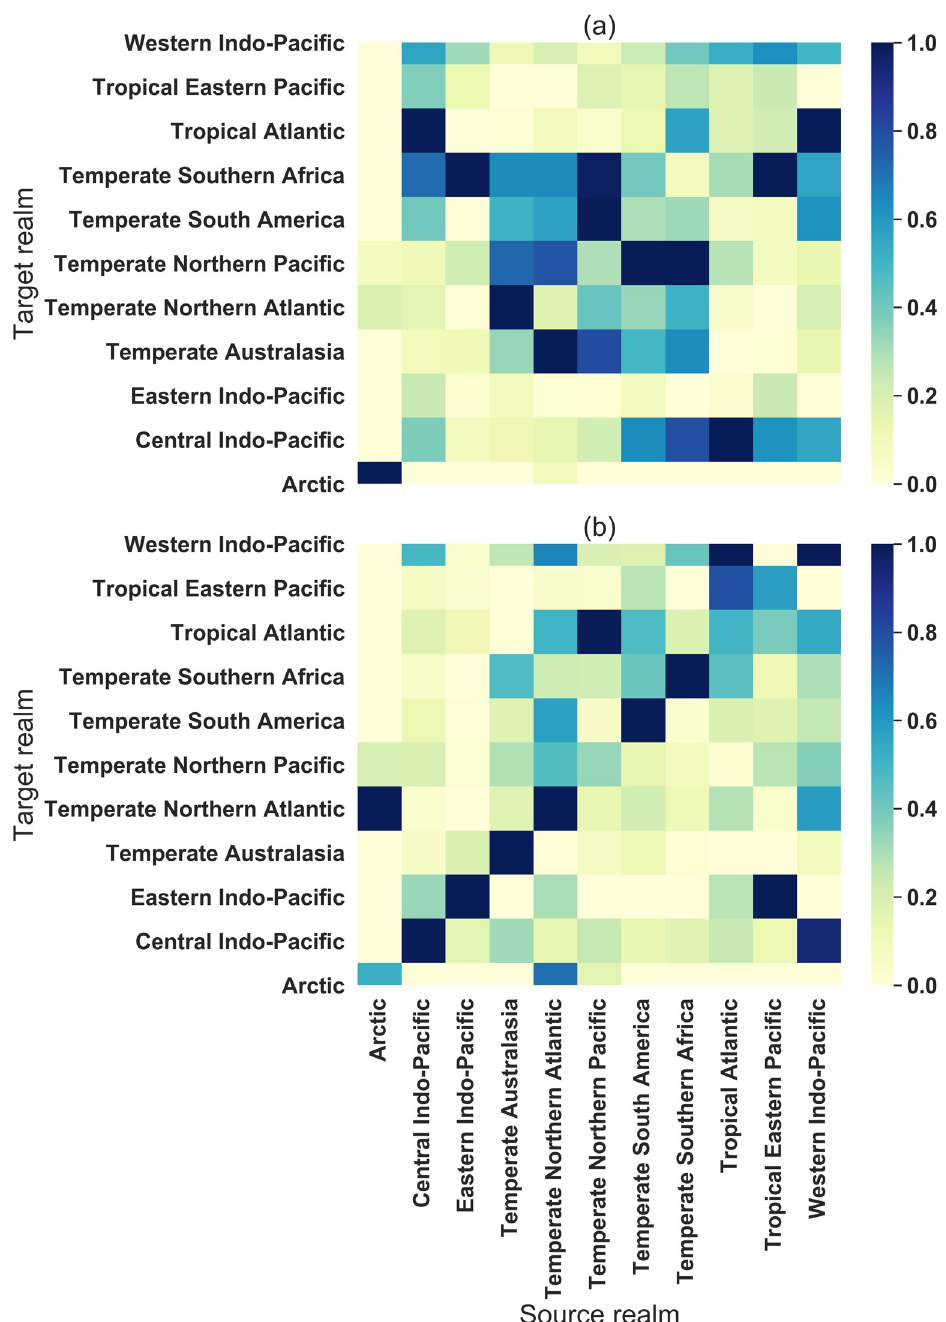
Fig 3. A heat-map of higher-order species flow resulting from ballast water (a) and biofouling (b) across major realms (a larger geographic scale that the ecoregion scale underlying other analyses). The y-axis indicates target realms and the x-axis are the source realms (x-axis is shared). The risks are normalized to be in the range of [0, 1]. The inter-realm risk is overall higher in ballast SF-HON (a), while most high-risk connections in biofouling SF-HON are within the same realms (b). Eastern-Indo Pacific has the highest risk of NIS introduction to Temp Southern Africa in ballast SF-HON (a), while in biofouling SF-HON the highest target realm for Eastern-Indo Pacific is Central Indo- Pacific (b). Temperate Northern Atlantic has a significantly high risk of introduction to Eastern-Indo Pacific in biofouling SF-HON (b).